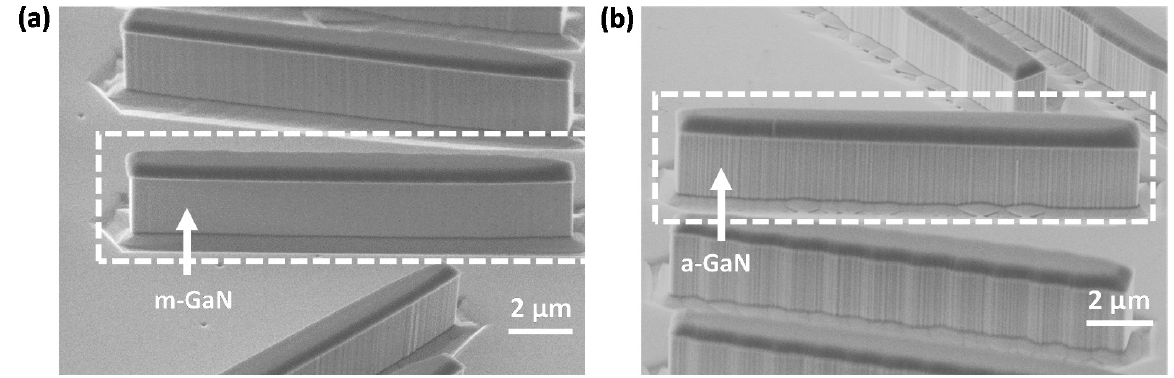
Figure 3. SEM images for m-GaN and a-GaN sidewalls after 30 min in TMAH solution; ( a ) m-GaN sidewall; ( b ) a- GaN